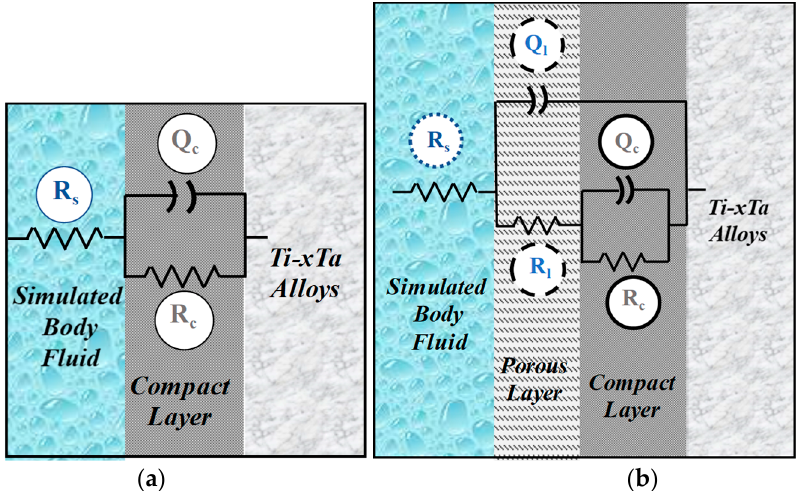
Figure 10. Equivalent circuits used for fitting the experimental data with: ( a ) one time-constant; ( b ) two time-constants.